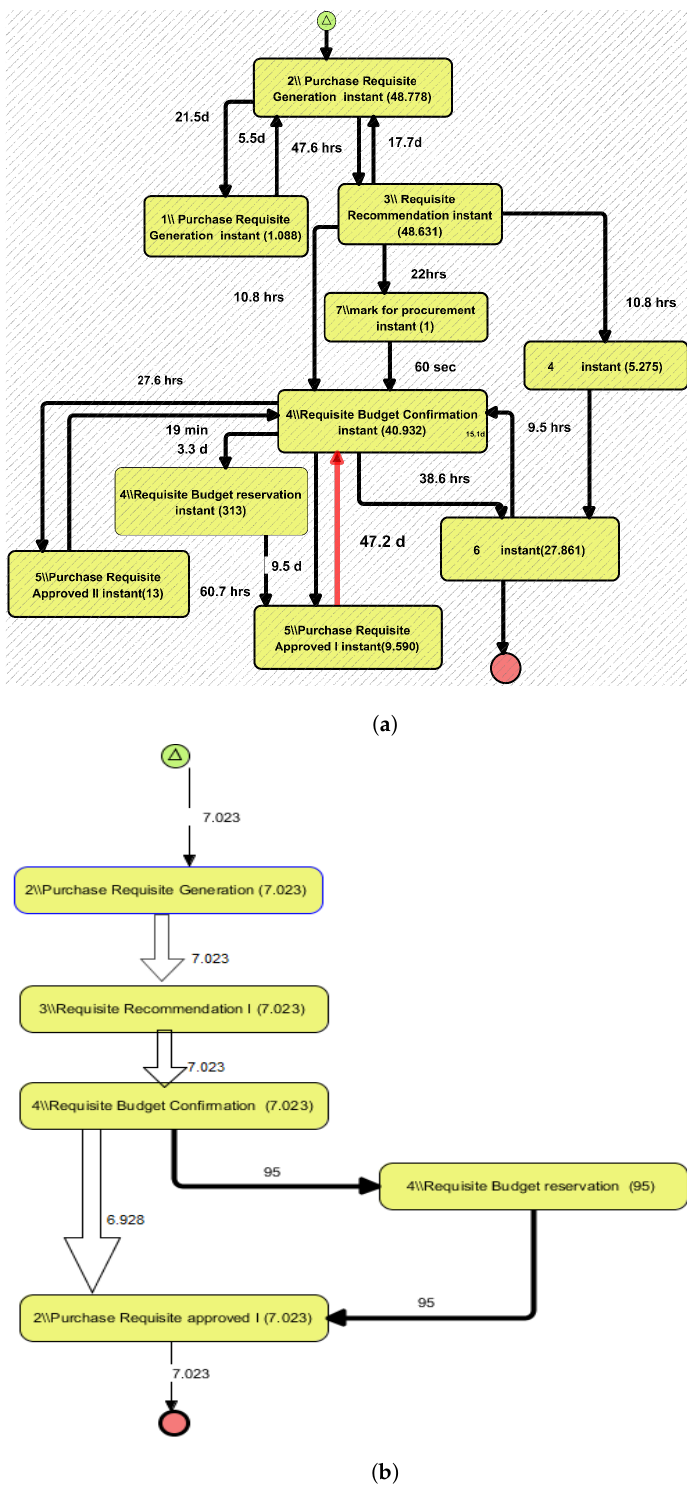
Figure 6. ( a ) Process map of original noisy data, and ( b ) process map of data after